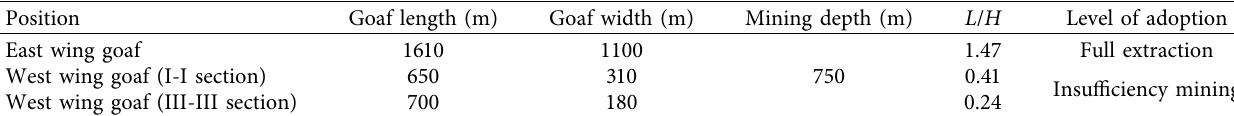
Table 1: Judgment table for district’s mining adoption level.